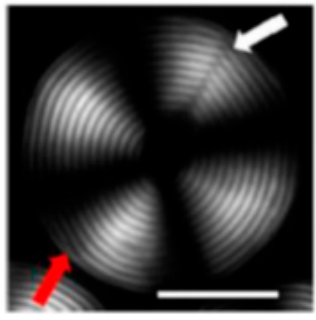
Figure 11. Polarized light microscope image of a CNC cholesteric microdroplet. The scale bar is 50 mm. The white arrow indicates the defect running perpendicular to the cholesteric layers. The red arrow indicates an edge dislocation parallel to the cholesteric layers. Reprinted from [41].